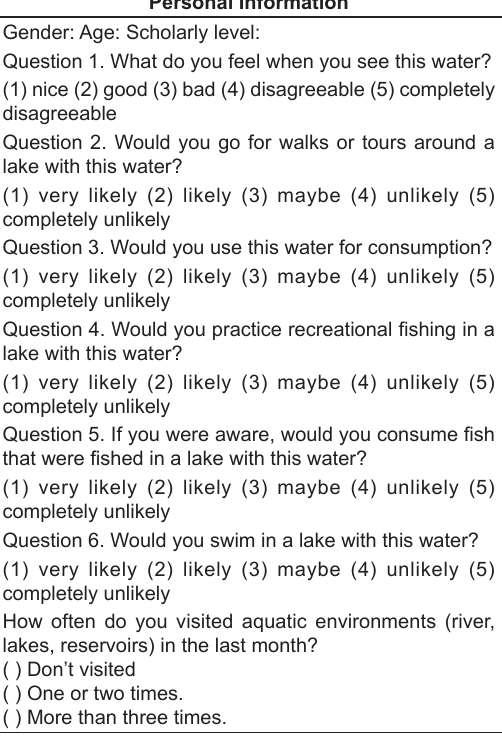
Table 3. Questionnaire applied to 100 interviewees seeking to assess their visual perception regarding water quality in the six mesocosms in-situ. We used only question 1 and 5 to 83 interviewees used pictures approach. The questionnaire was applied in